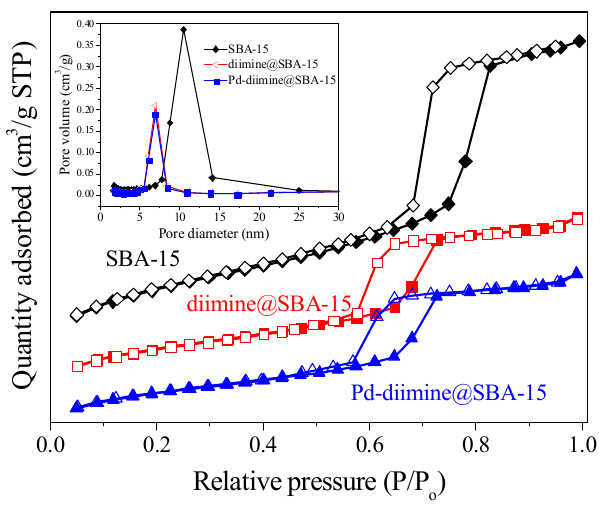
Figure 4. N 2 sorption isotherms and pore ‐ size distribution curves of SBA ‐ 15, diimine@SBA ‐ 15, and Pd ‐ diimine@SBA ‐ 15. Table 1. Textural parameters of SBA ‐ 15, diimine@SBA ‐ 15, and Pd ‐ diimine@SBA ‐ 15.